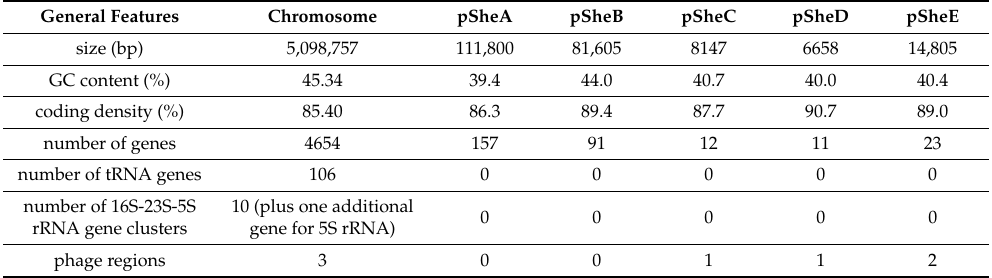
Figure 1. Physical maps of the chromosome and plasmids of Shewanella sp. O23S. Open reading frames are indicated by orange and dark green blocks. The innermost circle represents GC skew, whereas the larger ones—GC content, repeat regions and RNA genes, respectively. Table 1. General features of the Shewanella sp. O23S genome.